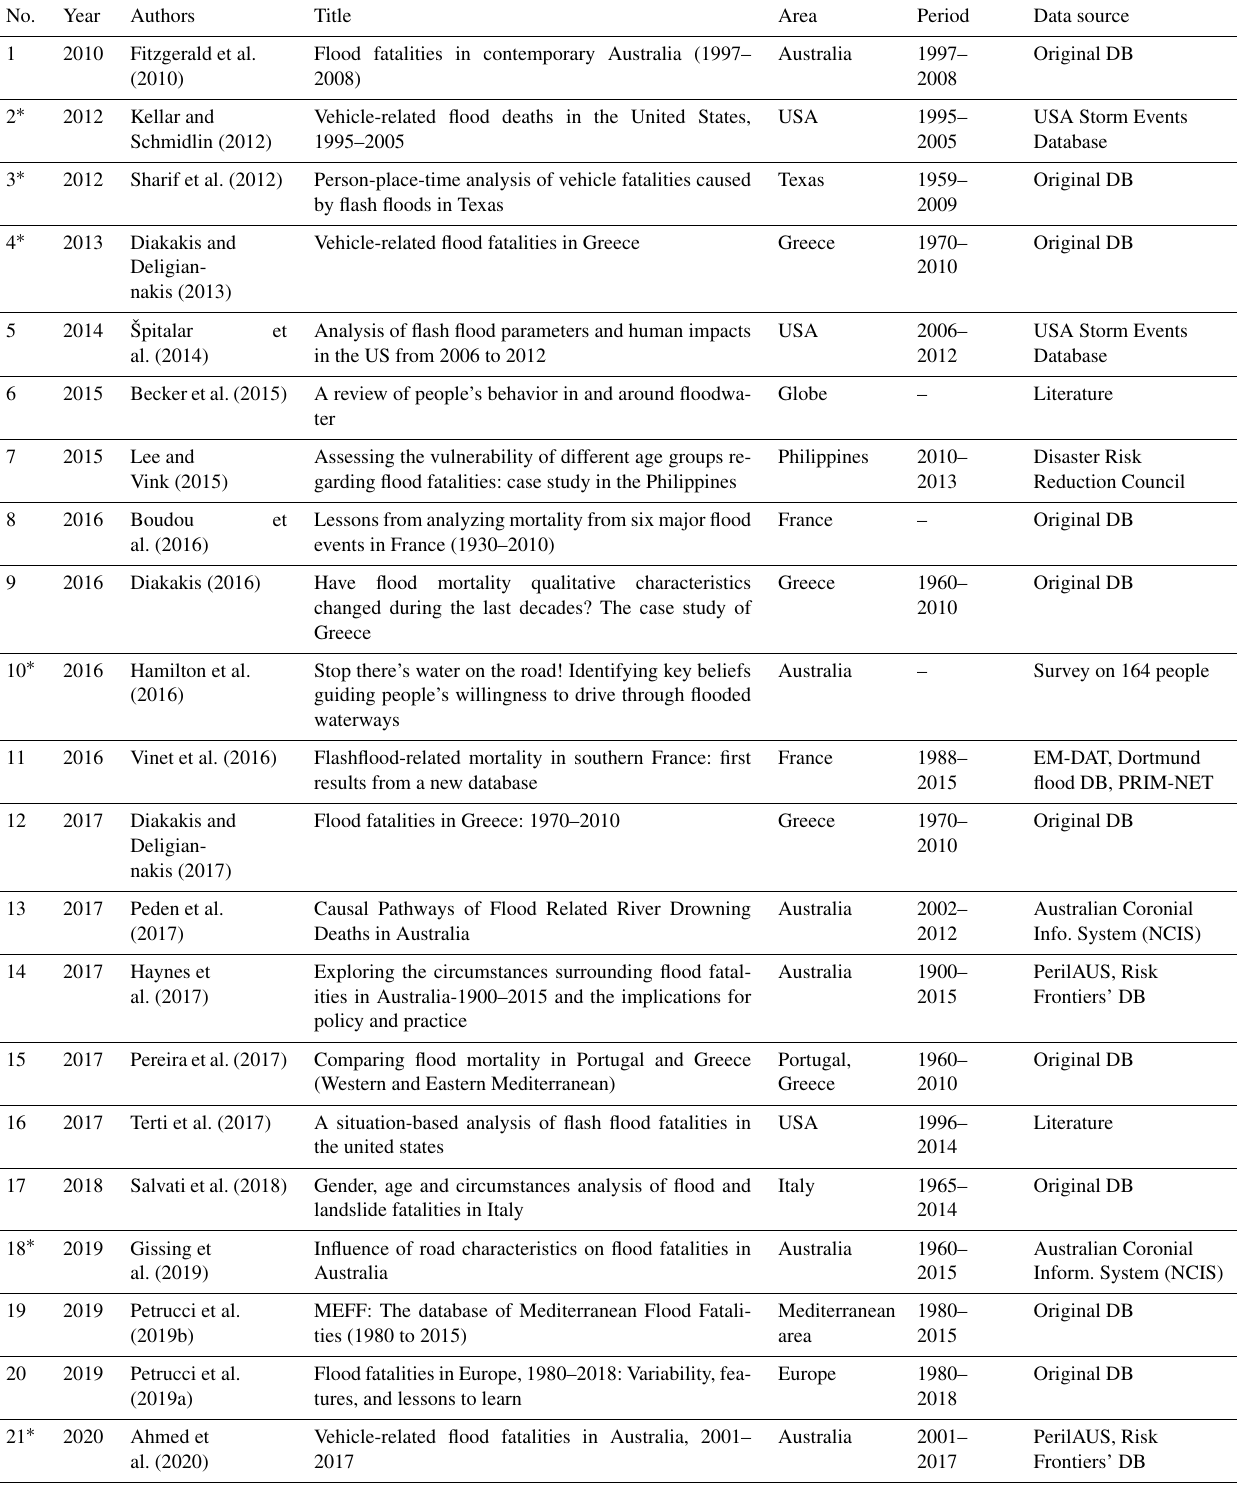
Table 1. Articles selected for quantitative analysis (in chronological order of publication). Papers labeled with ∗ focus on vehicle-related accidents; DB stands for